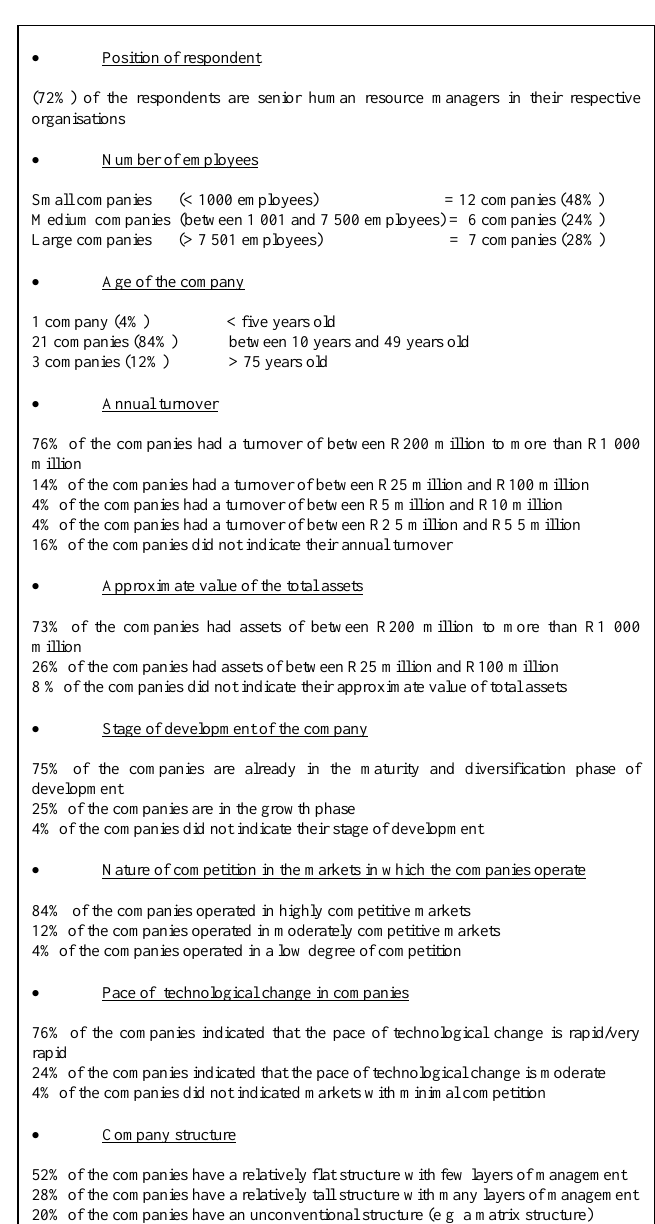
Table 4: Demographic information of the sample companies (N = 25)